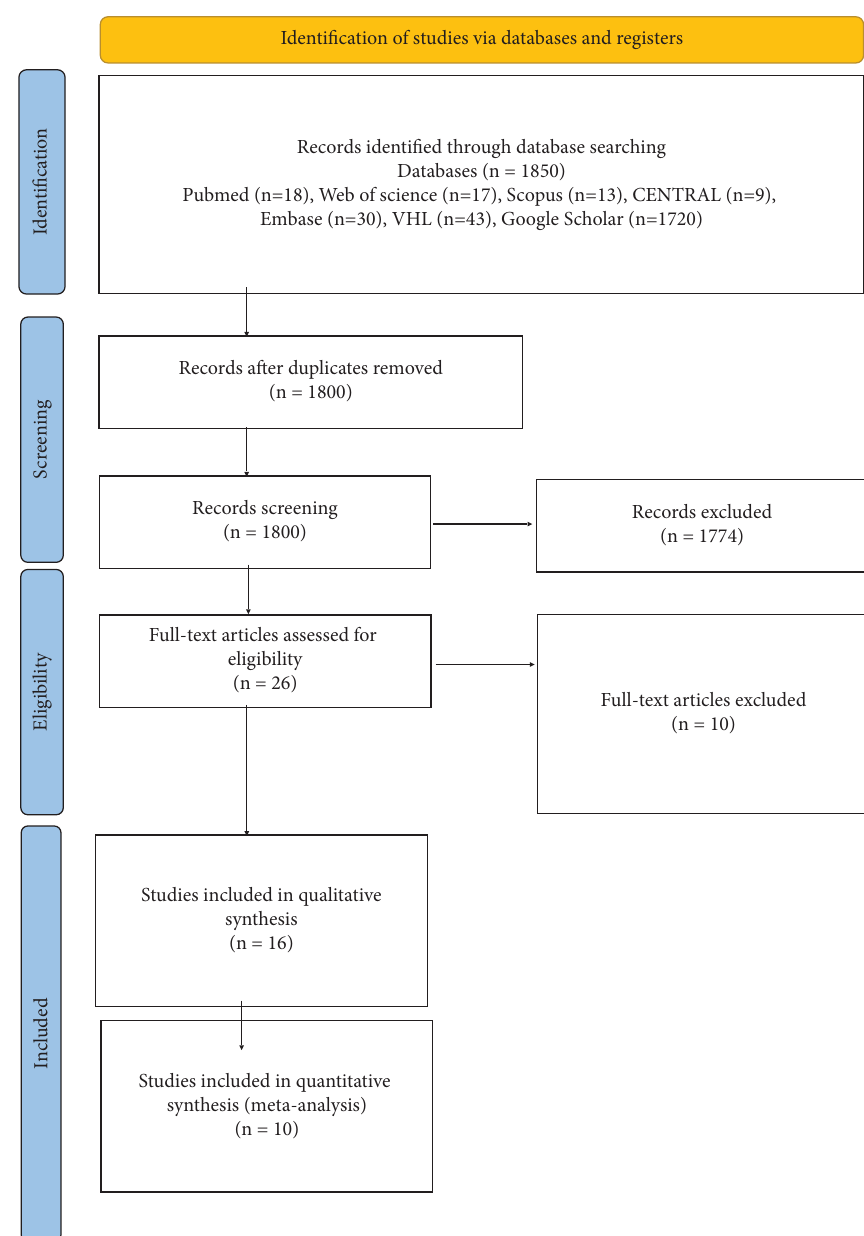
Figure 1: PRISMA fow diagram of the literature